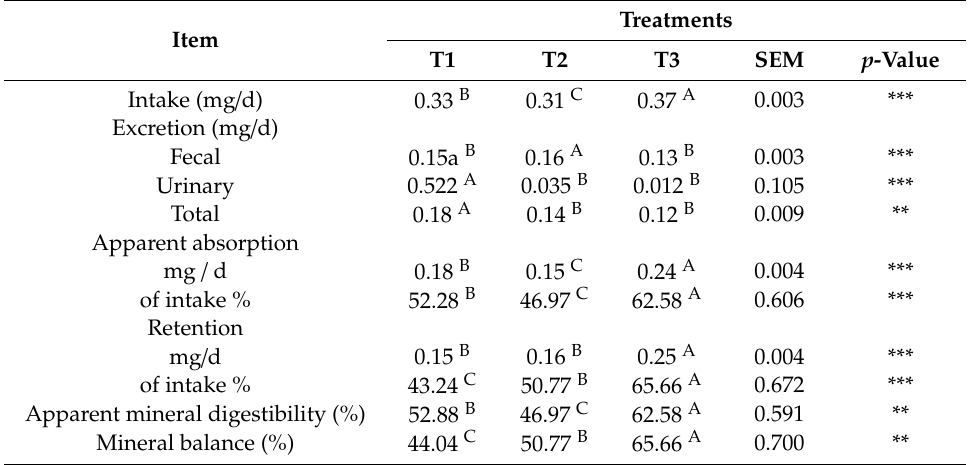
Table 3. Selenium balance by Dorper lambs fed with di ff erent levels of corn.